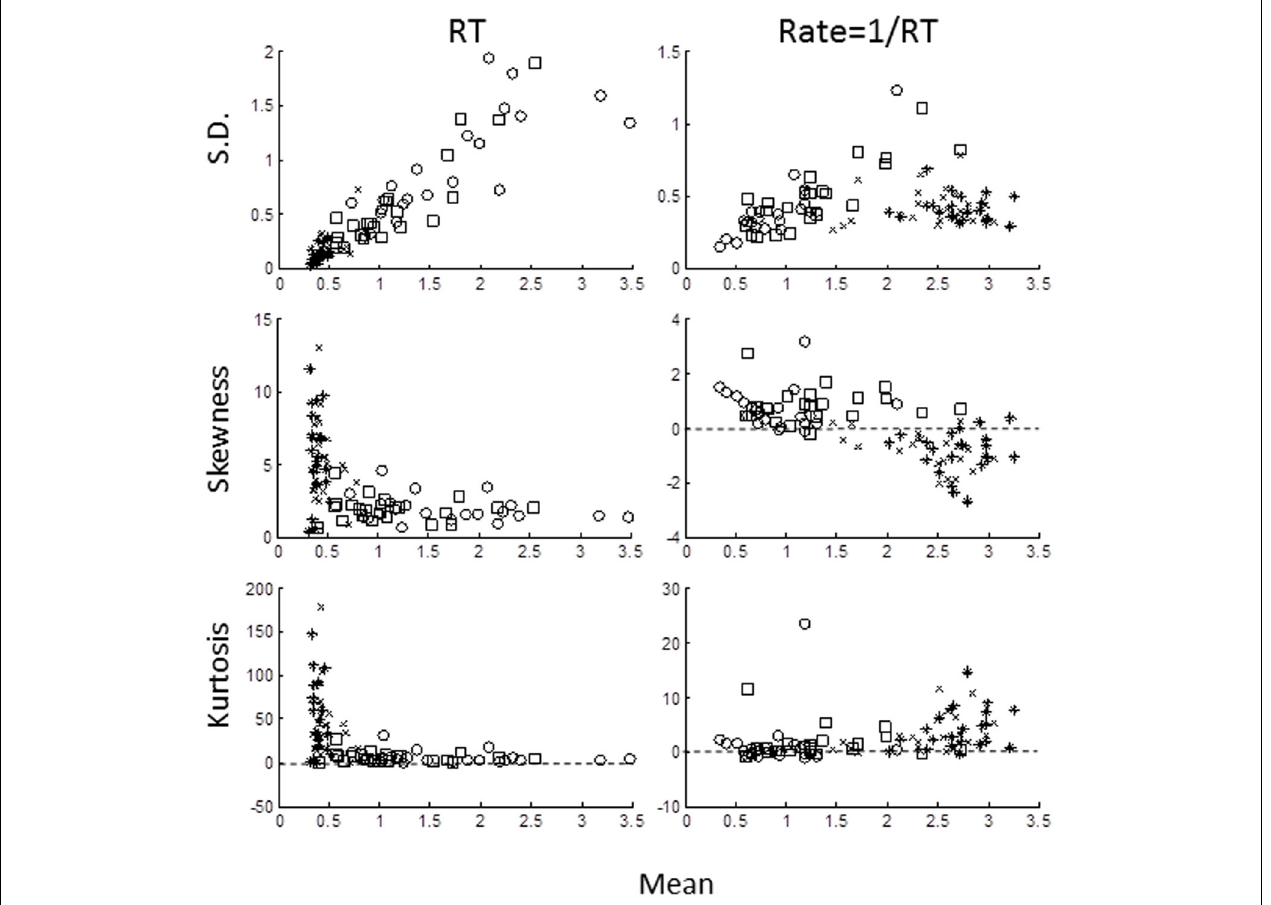
FIGURE 3 | Sample moments for RTs (left column) and rate (right column) plotted against mean for standard deviation (top row), skewness (middle row), and excess kurtosis (bottom row). Each symbol